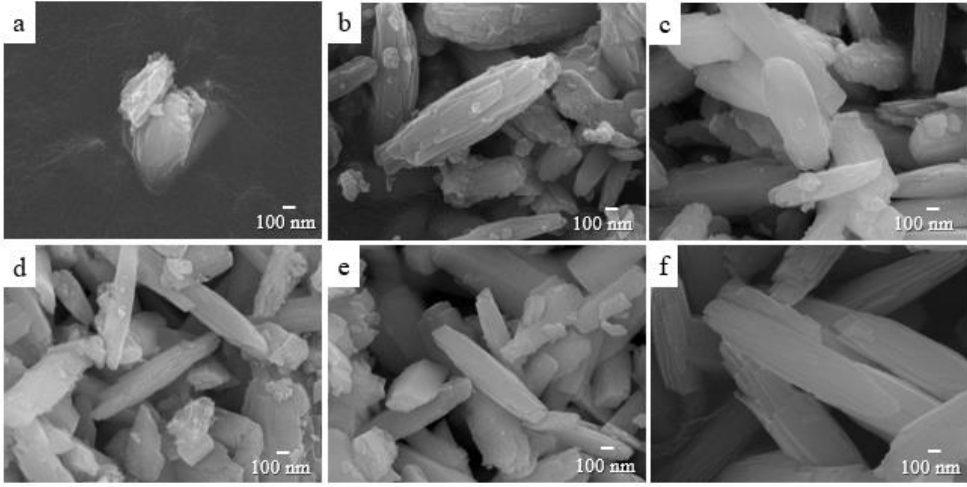
Figure 1. FESEM images of the precipitated amorphous nanostructure aged at 60 °C for ( a ) 10 min, and the precipitated α-GaOOH aged at 60 °C for ( b ) 1 h, ( c ) 1.5 h, ( d ) 2 h, ( e ) 3 h, and ( f ) 6 h.